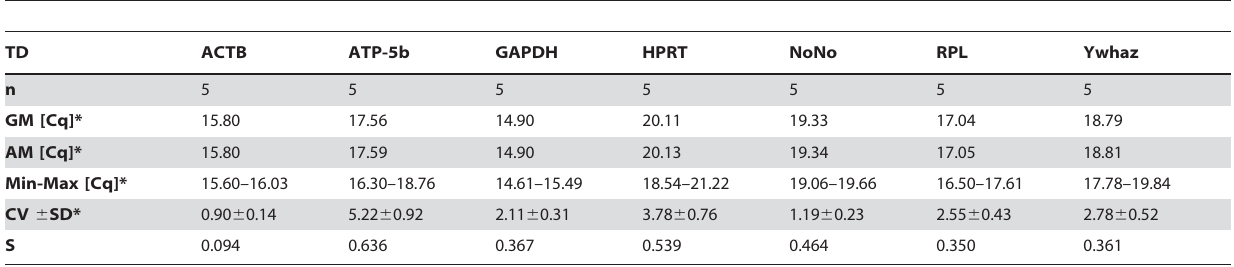
Table 5. Analysis of RGs expression stability during TD of adipocytes using BestKeeper and NormFinder algorithms.